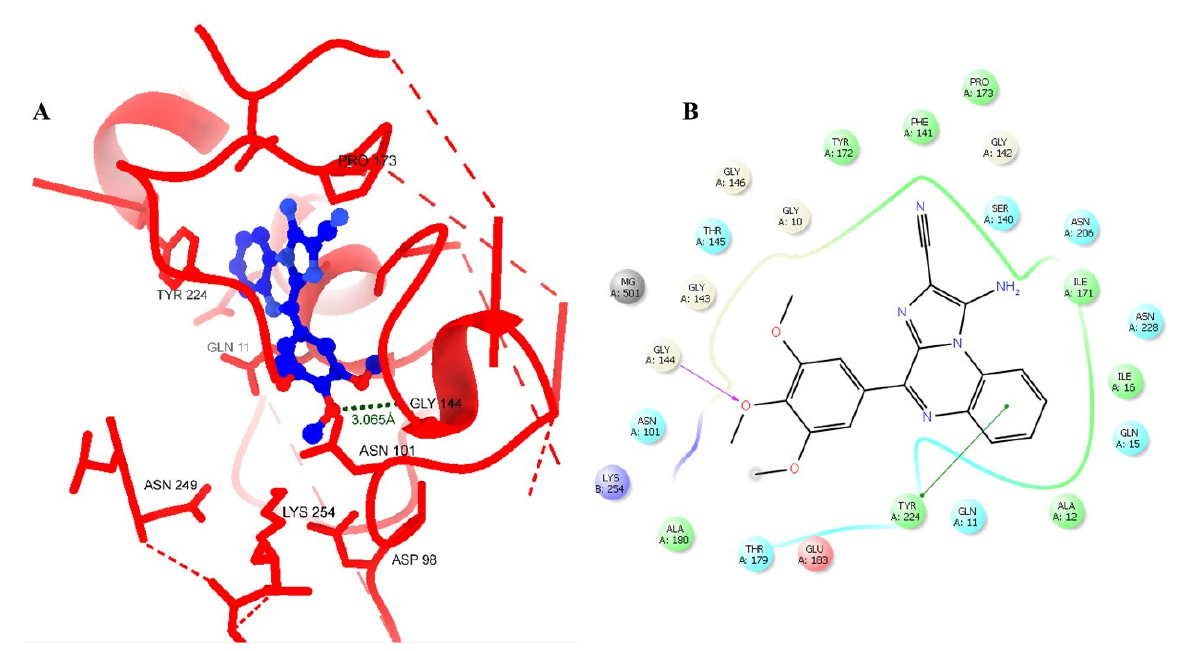
Figure 2. Illustration portraying the interaction pattern of 1A2 . ( A ) A 3D surface model and ( B ) a 2D interaction diagram within the colchicine-binding domain of tubulin (PDB: 1SA0).